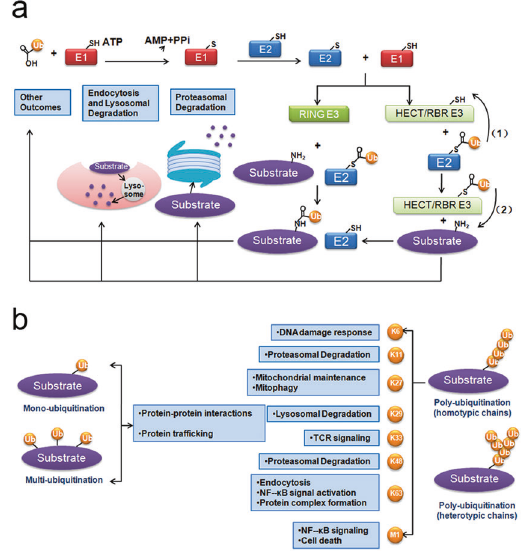
Fig. 1 Schematic diagram of ubiquitination. a The biological events during ubiquitination. b The classi fi cation of ubiquitination and corresponding biological